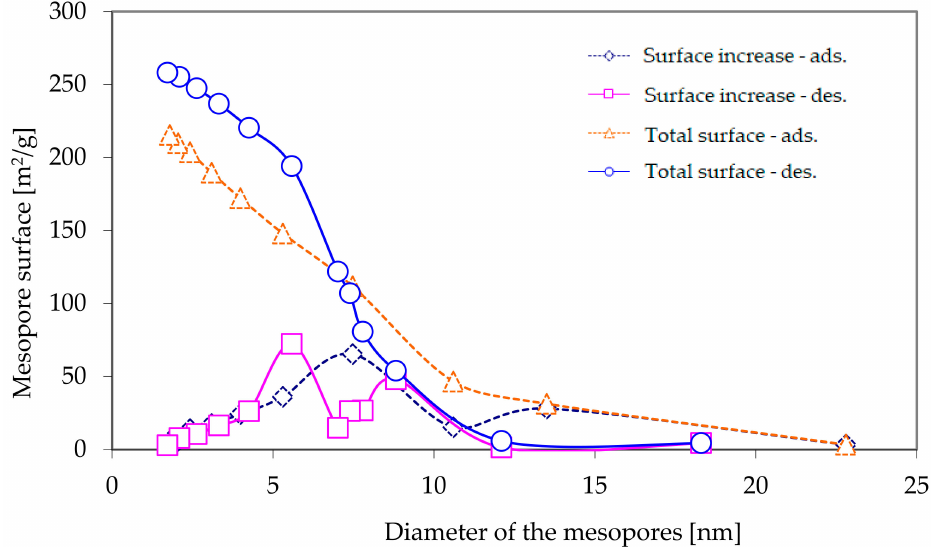
Figure 3. The total surface of mesopores and the increase in the surface of the mesopores as a function of their diameter, as calculated using the BJH method, based on nitrogen adsorption and desorption isotherms.